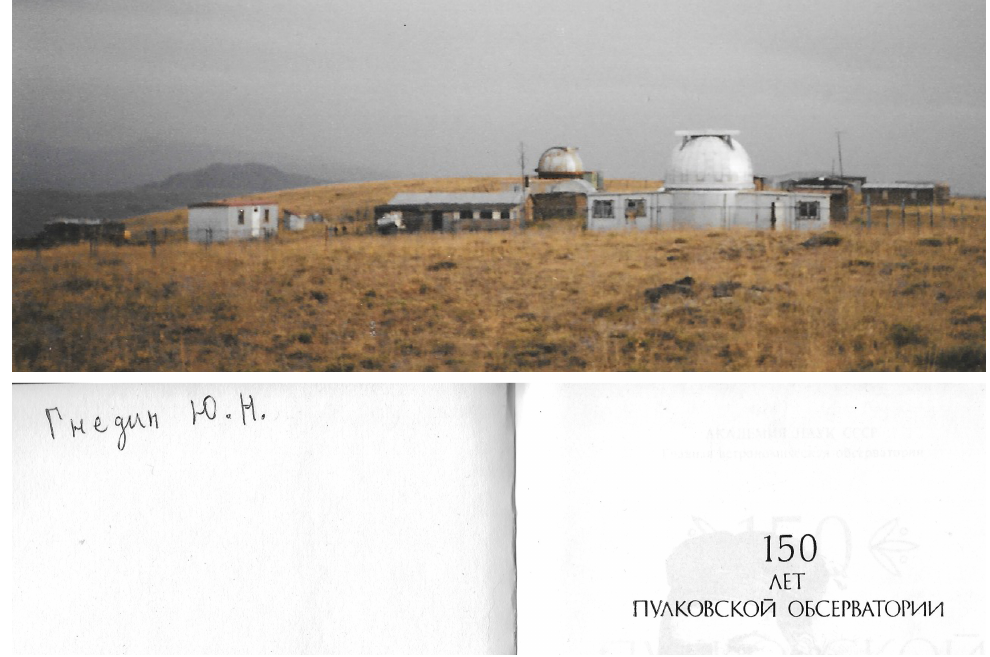
Figure 1. Top : wide view of the Ararat Scientific Site (taken by the author in August 1992). Bottom : inside cover of 150 Years of the Pulkovo Observatory , a souvenir from